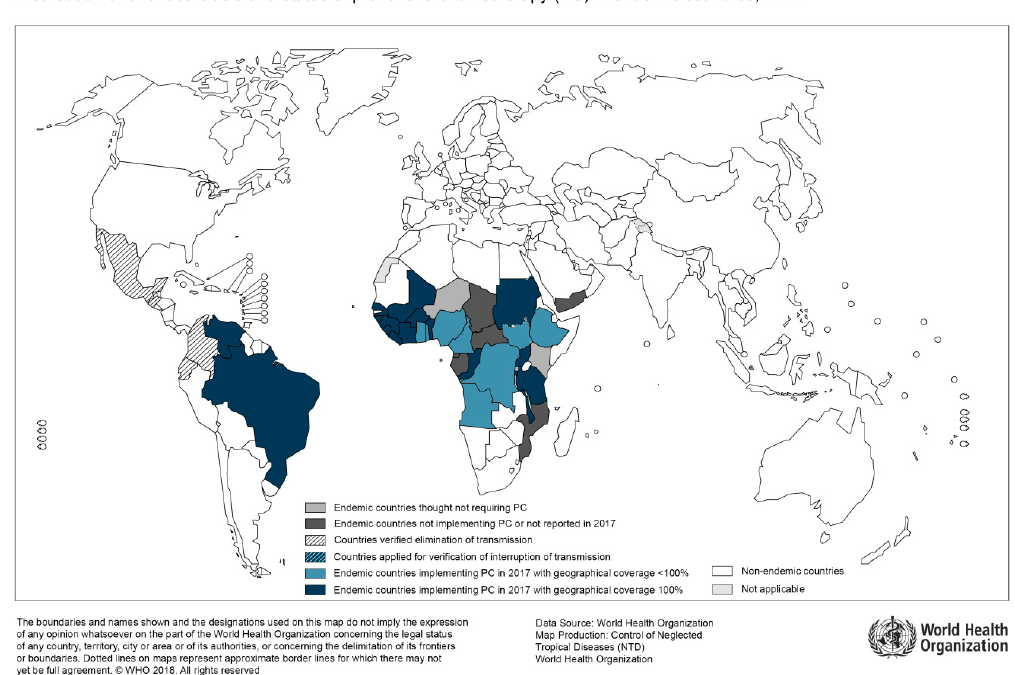
Figure 3. Distribution of Onchocerciasis, 2017 (Source: WHO; website: http://gamapserver.who.int/mapLibrary/Files/Maps/Onchocerciasis_2017.png.